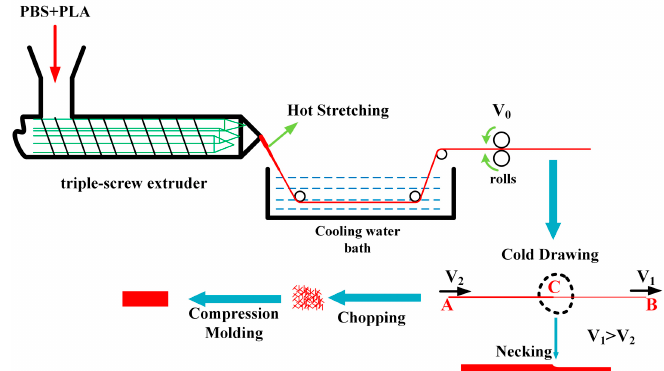
Figure 1. Scheme of the process for PBS/PLA in-situ submicrofibrillar composites preparation.